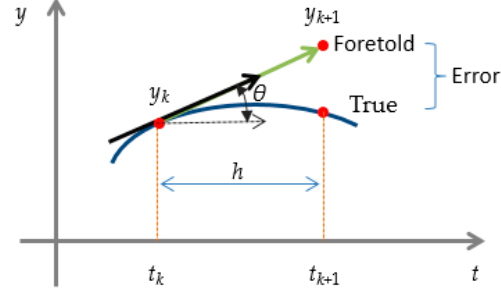
Figure 3. Graphic representation of the general solution using numerical methods.